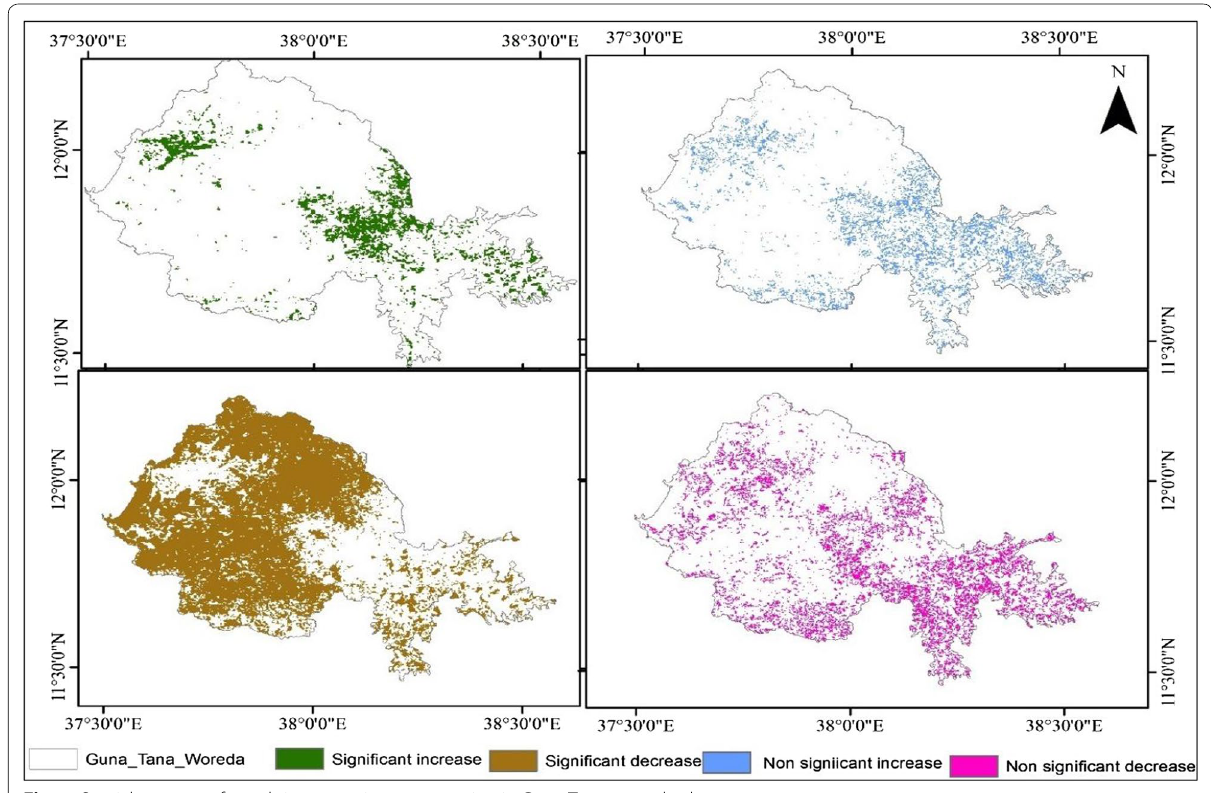
Fig. 4 Spatial patterns of trends in vegetation regeneration in Guan-Tana watershed